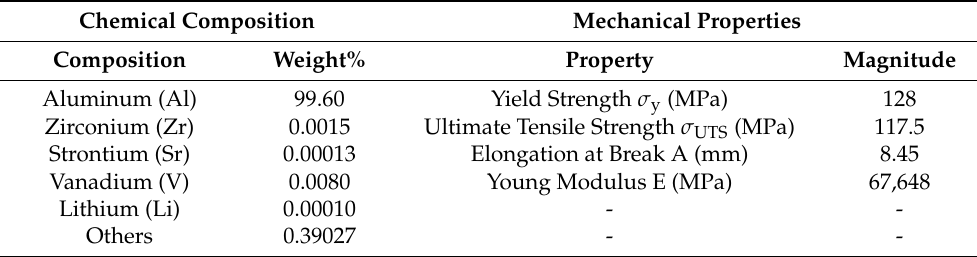
Table 2. Welding parameter levels obtained for experiment parametric study.